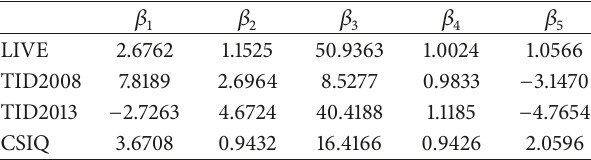
Table 2: Numerical values of